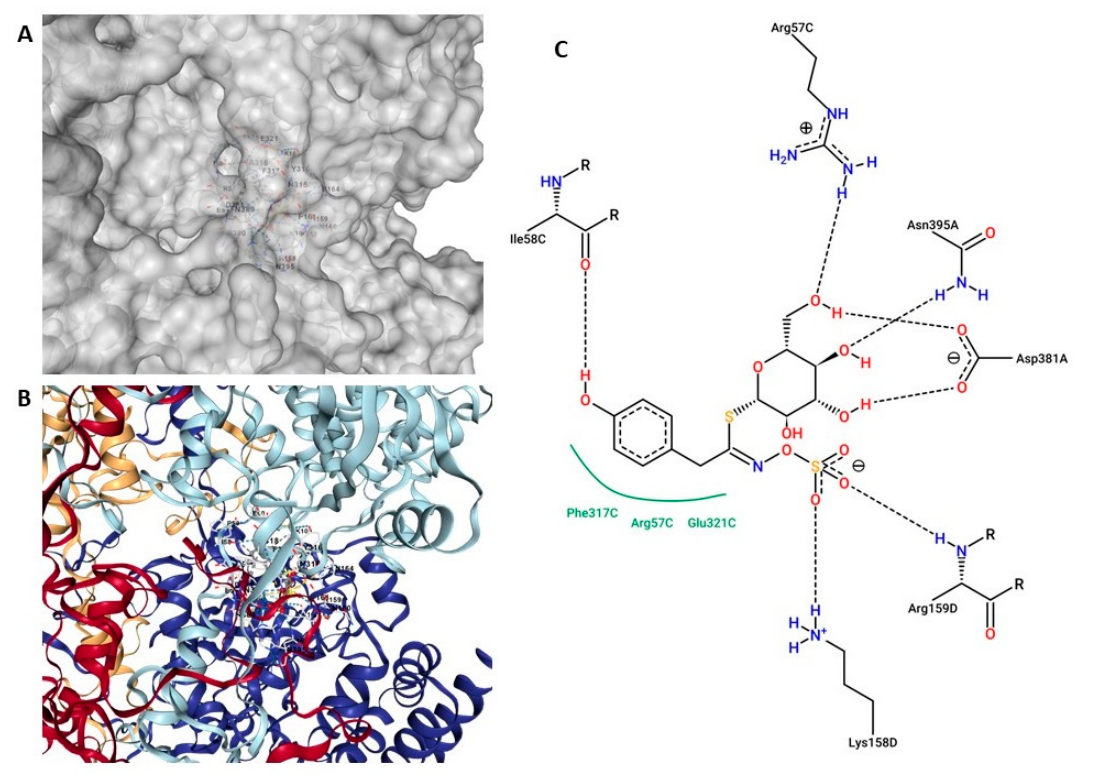
Figure 7. Docking results of the glucosinalbin–catalase complex. The binding site of the complex in space-filling view ( A ) and ribbon view ( B ), and the amino acids and chemical bonds involved in the interaction with catalase in a PoseView 2D interaction diagram ( C ).